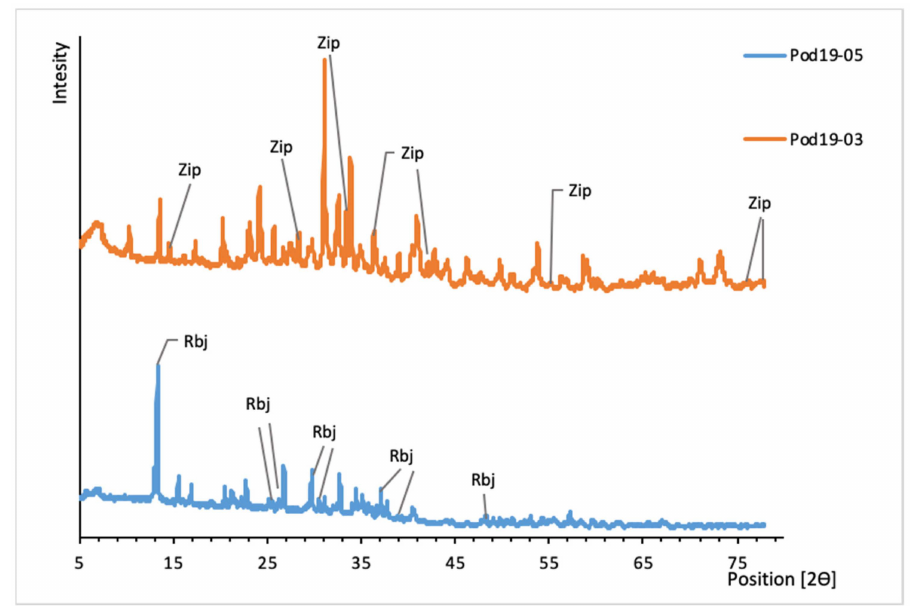
Figure 11. XRD patterns of uranyl sulfates from Podg ó rze mine. Rbj, rabejacite; Zip, zippeite.